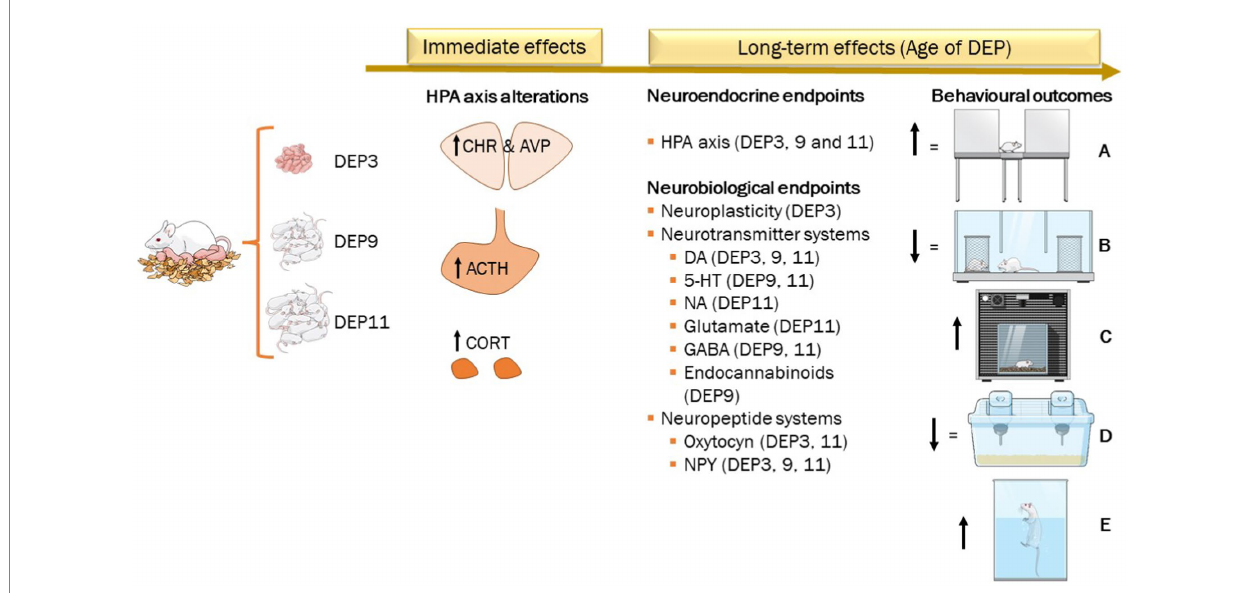
FIGURE 1 Immediate effects of maternal deprivation (DEP) on postnatal days (PND) 3 (DEP3), 9 (DEP9) or 11 (DEP11) on the hypothalamic–pituitary–adrenal (HPA) axis and the long-term effects neurobiological and behavioural endpoints. Although DEP increases corticosterone (CORT) levels, the magnitude of this effect depends on the age. (A) Anxiety-like behaviour measured in the elevated plus maze, (B) Social investigation test, (C) Prepulse inhibition, (D) Sucrose preference tests, and (E) Immobility in the forced swim test. Images were obtained from Mind the Graph